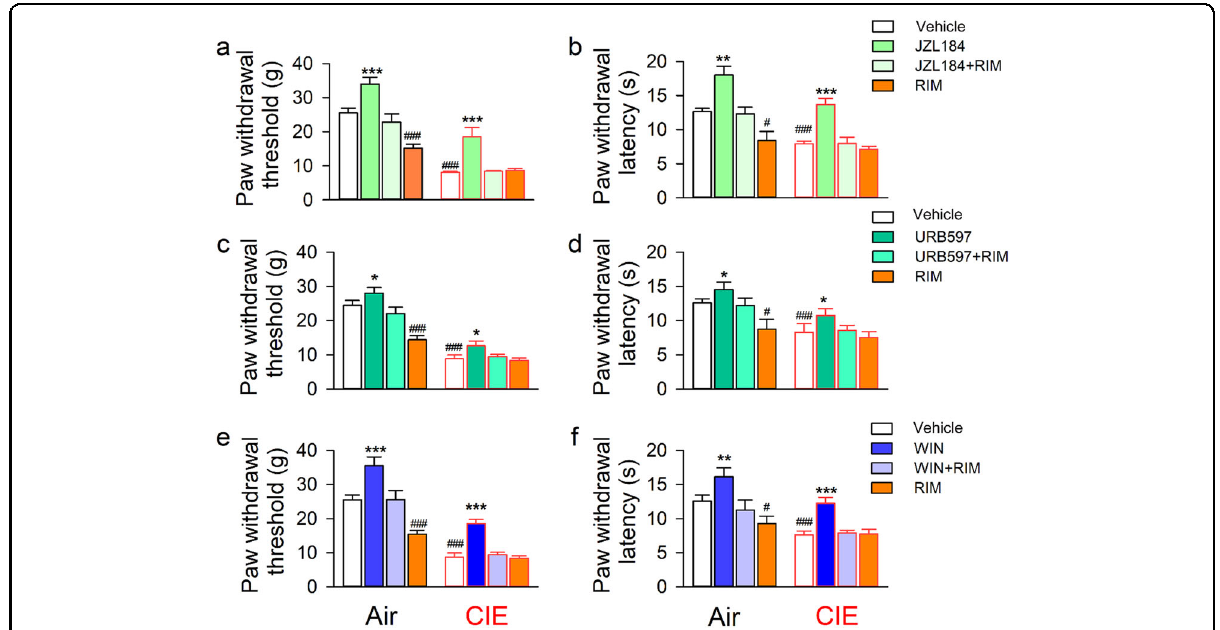
Fig. 3 Inhibiting LHb MAGL or FAAH or activating CB1R has an analgesic effect in both CIE and air-exposed rats. Adult male Long-Evans rats underwent CIE or air exposure for 8 weeks. At 24 h abstinence from the last vapor exposure, these rats randomly received bilateral intra-LHb infusion of JZL184 (MAGL inhibitor, n = 13 rats/ group), URB597 (FAAH inhibitor, n = 14 rats/group), or WIN 55,212-2 (CB1R agonist, n = 14 rats/group) alone or combined with rimonabant (RIM, an inverse CB1R agonist) 30 min before the behavioral test. The bar graphs summarize the effect of these compounds on the paw withdrawal threshold (PWT, a , c , and e ) or latency (PWL, b , d , and f ) in all subjects tested. All data are expressed as mean ± SEM. ### p < 0.001 vs vehicle or Air group; * p < 0.05, ** p < 0.01, *** p < 0.001 vs vehicle, JZL + RIM or RIM within each vapor group, revealed by two-way RM ANOVA followed by Bonferroni post-hoc